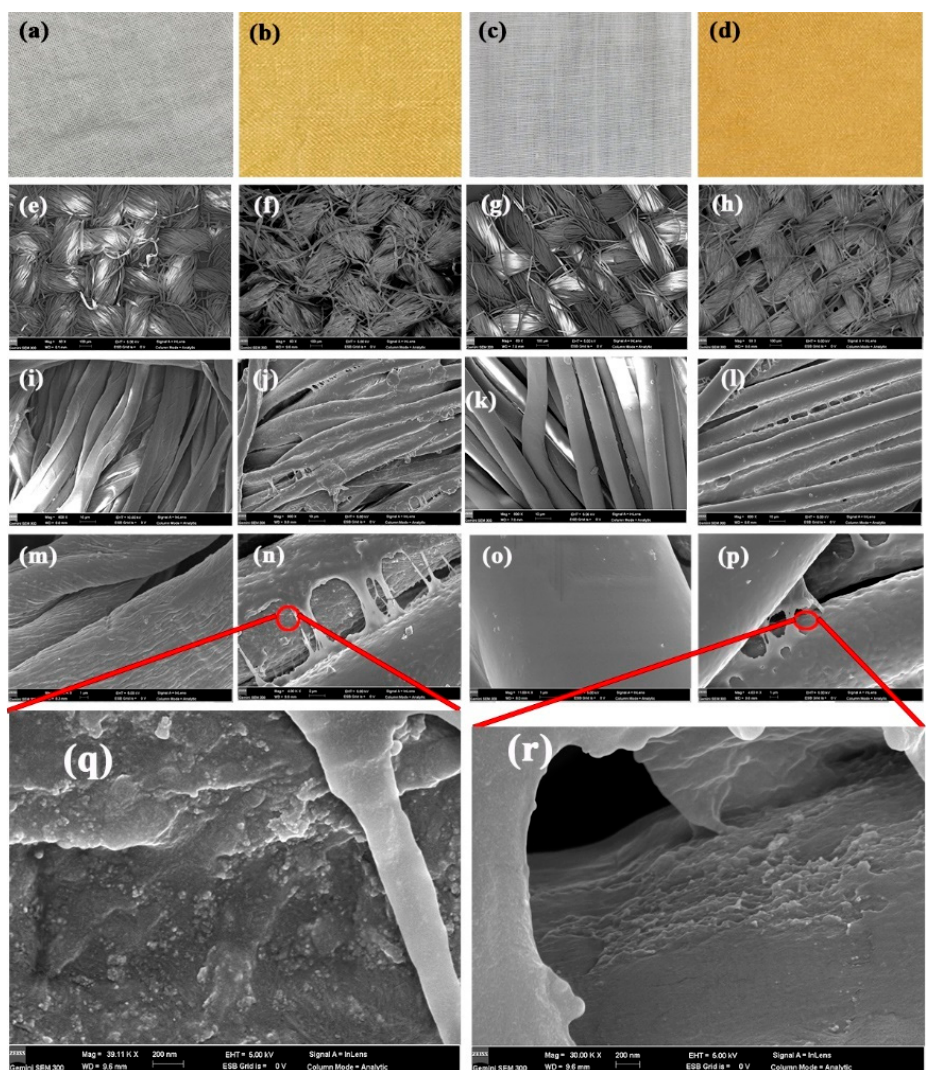
Figure 5. Optical images ( a – d ), SEM images ( e – p ) of untreated cotton ( a , e , i , m ), treated cotton ( b , f , j , n , q ), untreated polyester ( c , g , k , o ), and treated polyester fabrics ( d , h , l , p , r